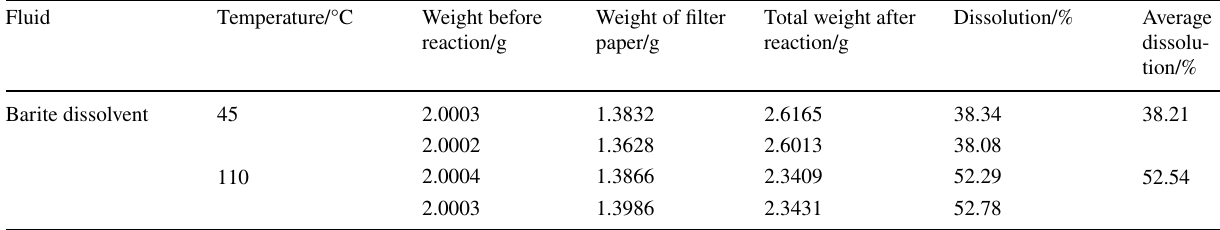
Table 5 Dissolution experiment results of barite